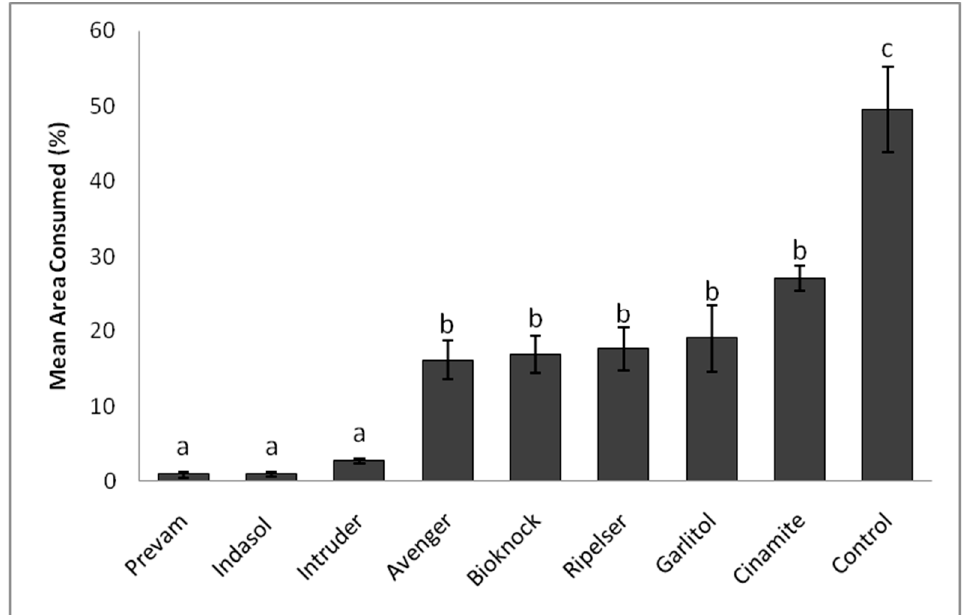
Figure 2. Mean area (%) of leaves consumed by 2nd instar larvae of C. chalcites ). Different letters above the bars indicate a significant difference among the groups according to ANOVA followed by Tukey’s HSD test ( p < 0.05).